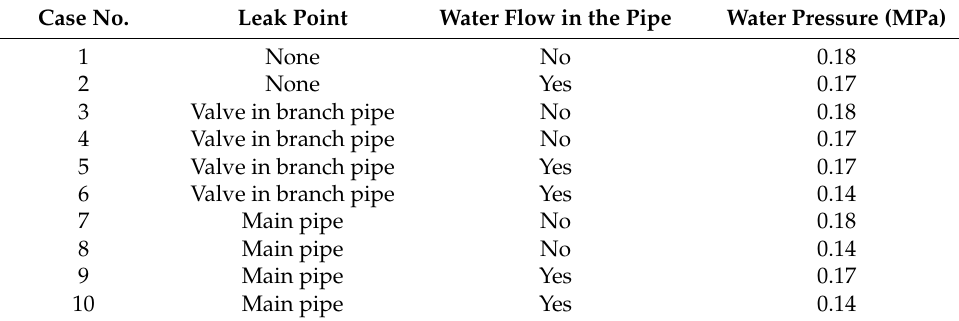
Table 4. Leak testing